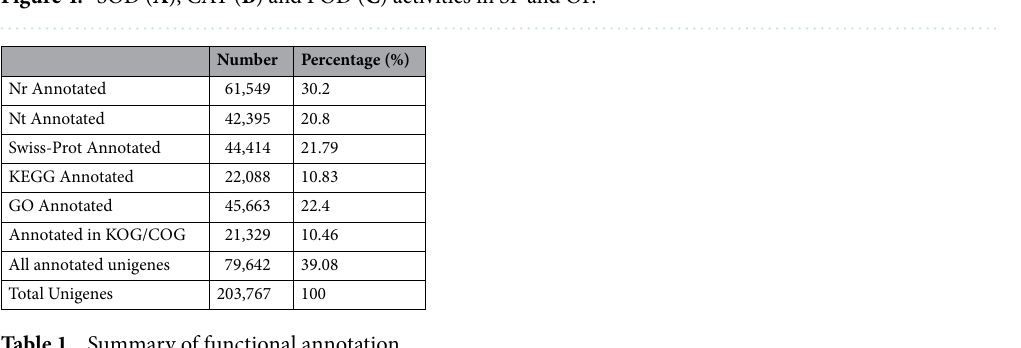
Table 1. Summary of functional